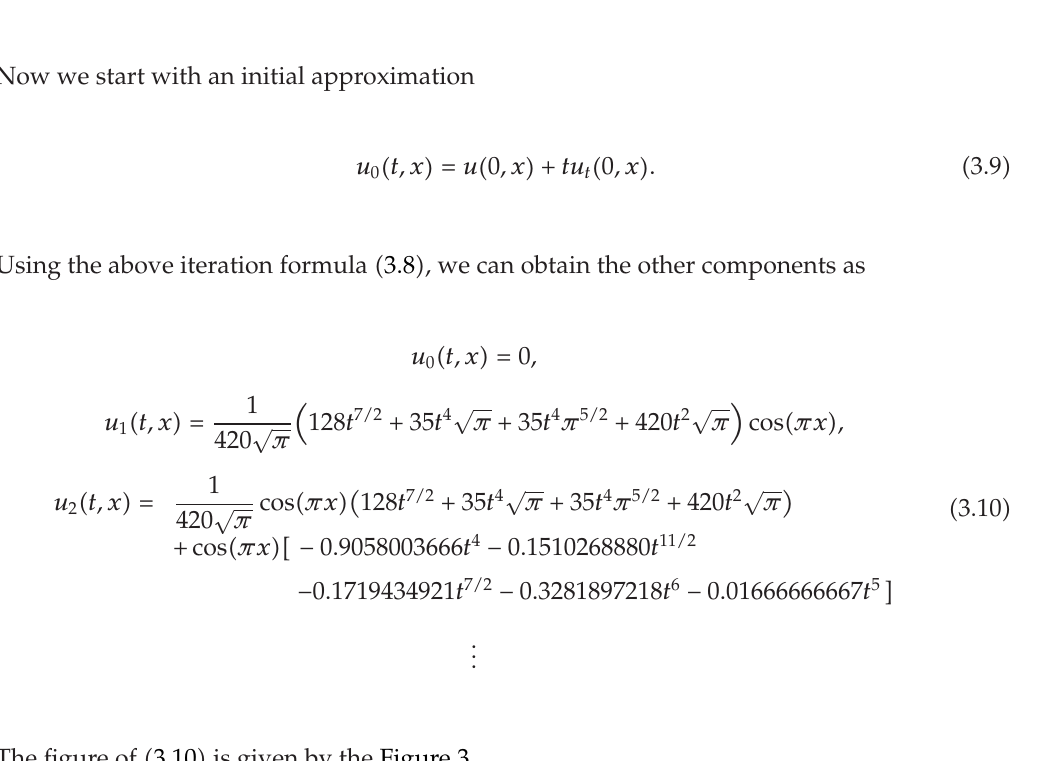
The figure of (cid:3) 3.10 (cid:4) is given by the Figure